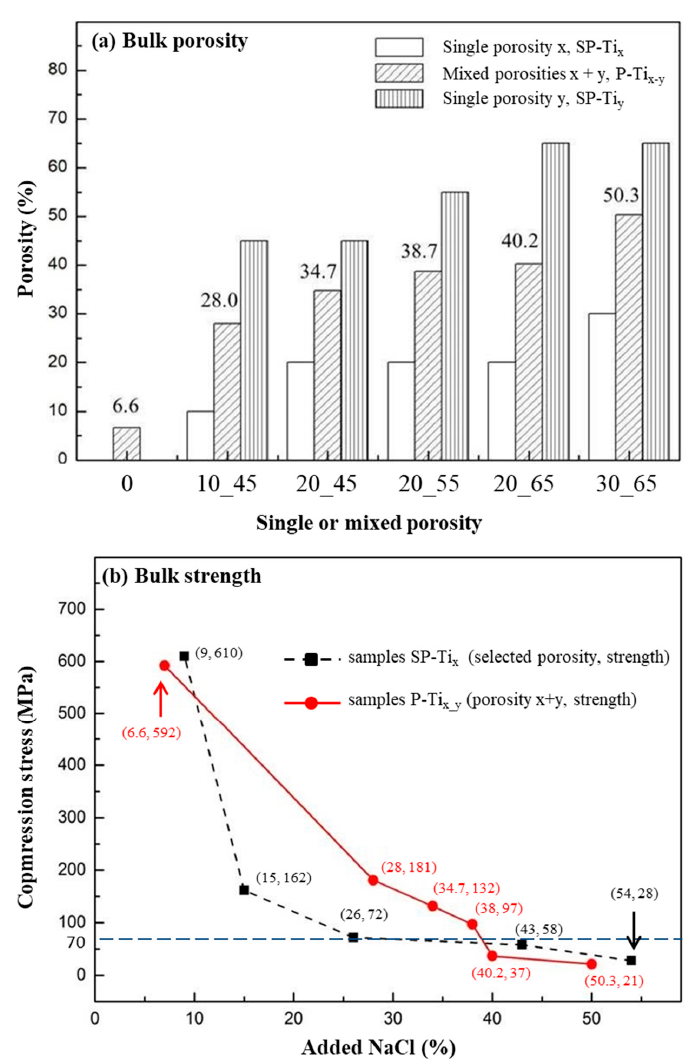
Figure 2. ( a ) The experimental values of mixed porosities, x + y of P-Ti x_y , compared with the theoretical values of single porosity, x or y (SP-Ti x or SP-Ti y ). ( b ) The measured compression stress of P-Ti x_y (in solid line) was compared with that of P-Ti of different porosities (in dotted line). The individual values were obtained and expressed as (porosity, strength).